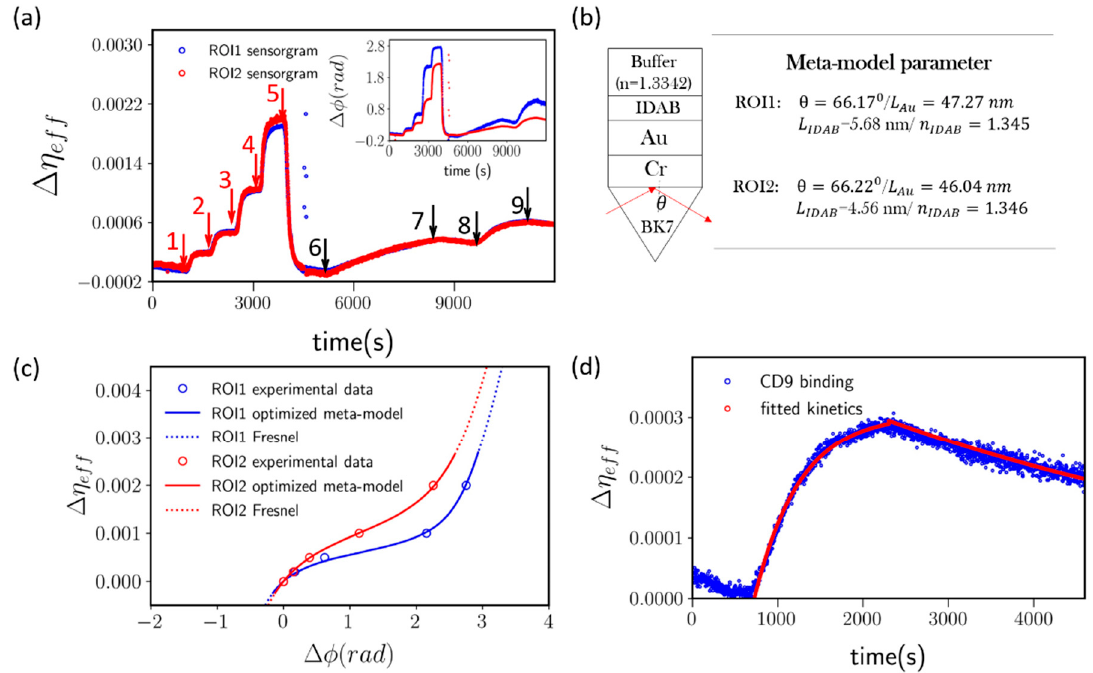
Figure 6. ( a ) 4175-LuT exosomal surface integrin α 6 β 4 detection sensorgram, obtained using IDAB modified SPR chip. The blue trace is the sensorgram collected from ROI1 of microfluidic channel and red trace is collected from ROI2 for comparison. Inset: the phasogram of the exosome detection process before processed by the proposed algorithm. ( b ) The optimized meta-model parameters obtained for the ROIs under study. ( c ) The meta-models obtained for the ROIs under Scheme 1. red circle represent the data from ROI2. The meta-model is noted in blue line for ROI1, and red line for ROI2. The optimized Fresnel model is plotted in blue dotted line (ROI1) and red dotted line (ROI2). ( d ) CD9 sensorgram from ROI1 in blue trace and fitted Langmuir model in red trace.